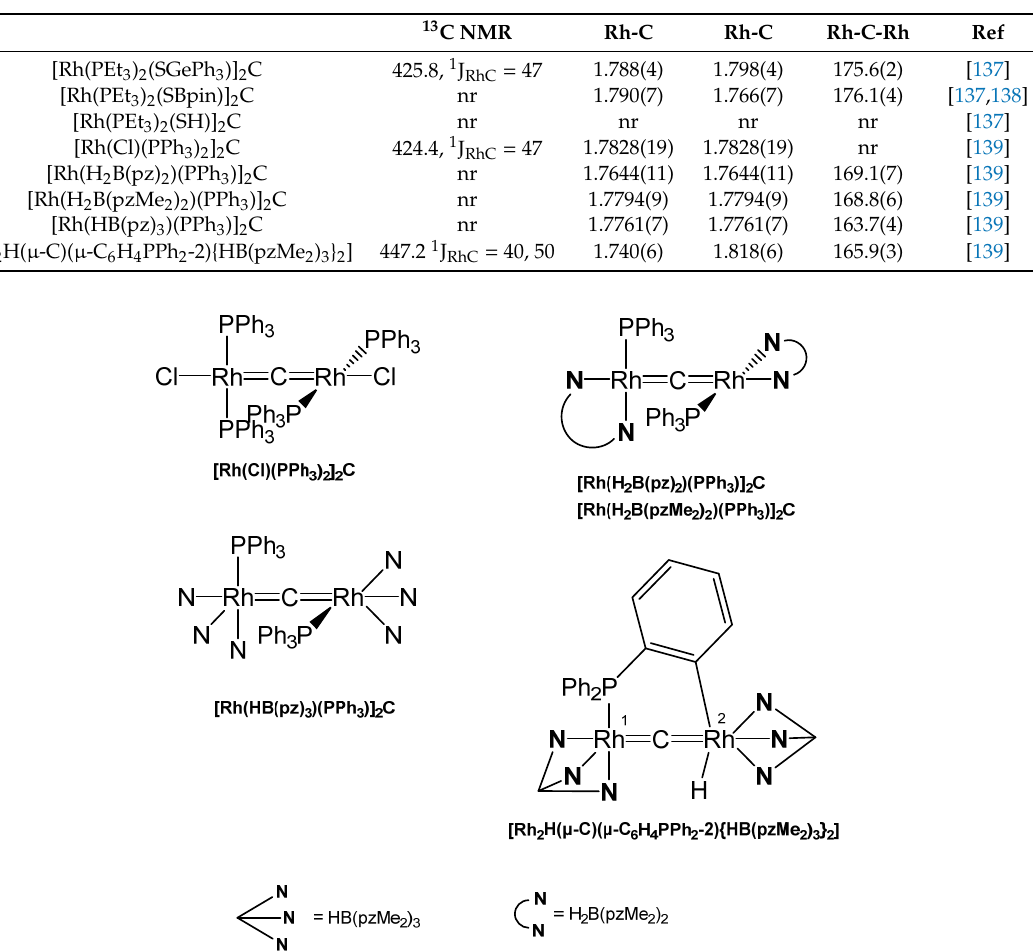
Table 19. Rh-C distances (in Å) and Rh-C-Rh angles (in deg). 13 C NMR of the bridging carbon atom in ppm.